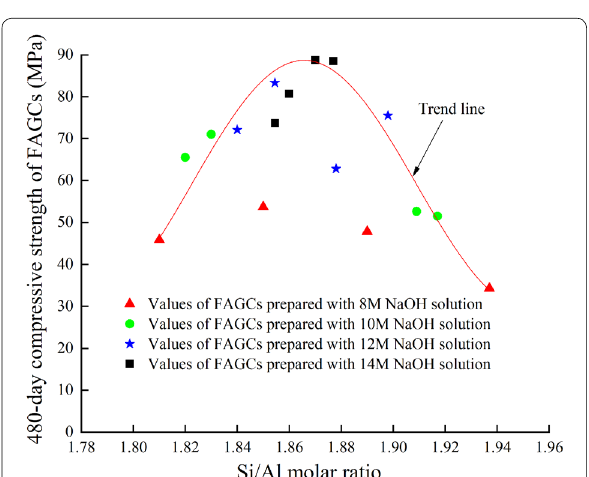
Fig. 4 The relationship between 480-day compressive strength of FAGC with Si/Al ratio.